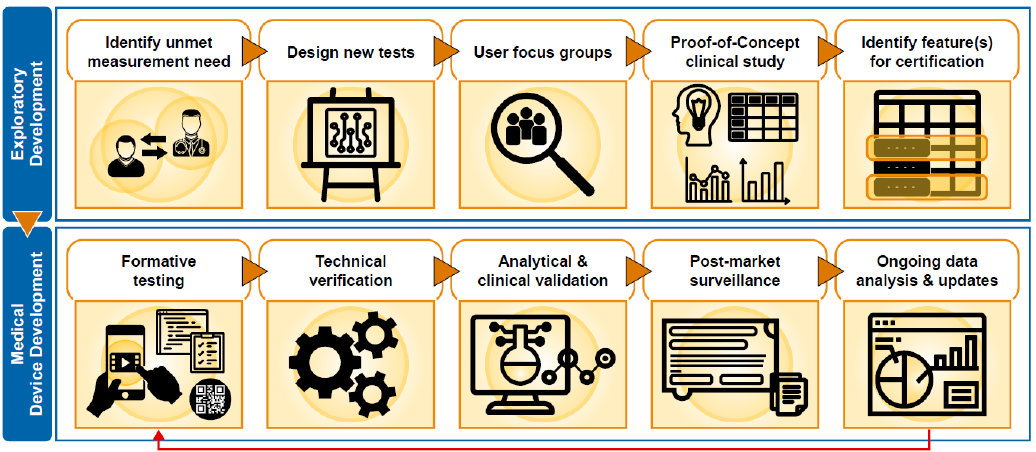
Figure 3. Development of Floodlight™ MS software as a medical device.